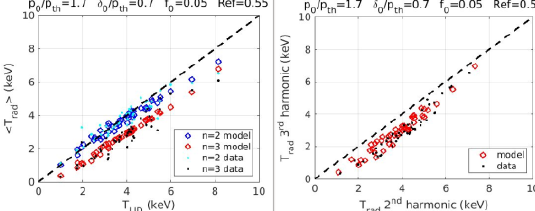
Fig. 12. As in Figs. 7-10, for DT discharges and data points with ICRH only. Perturbation parameters: f 0 = 0.05, p 0 /p th = 1.7,  /p th = 0.7.